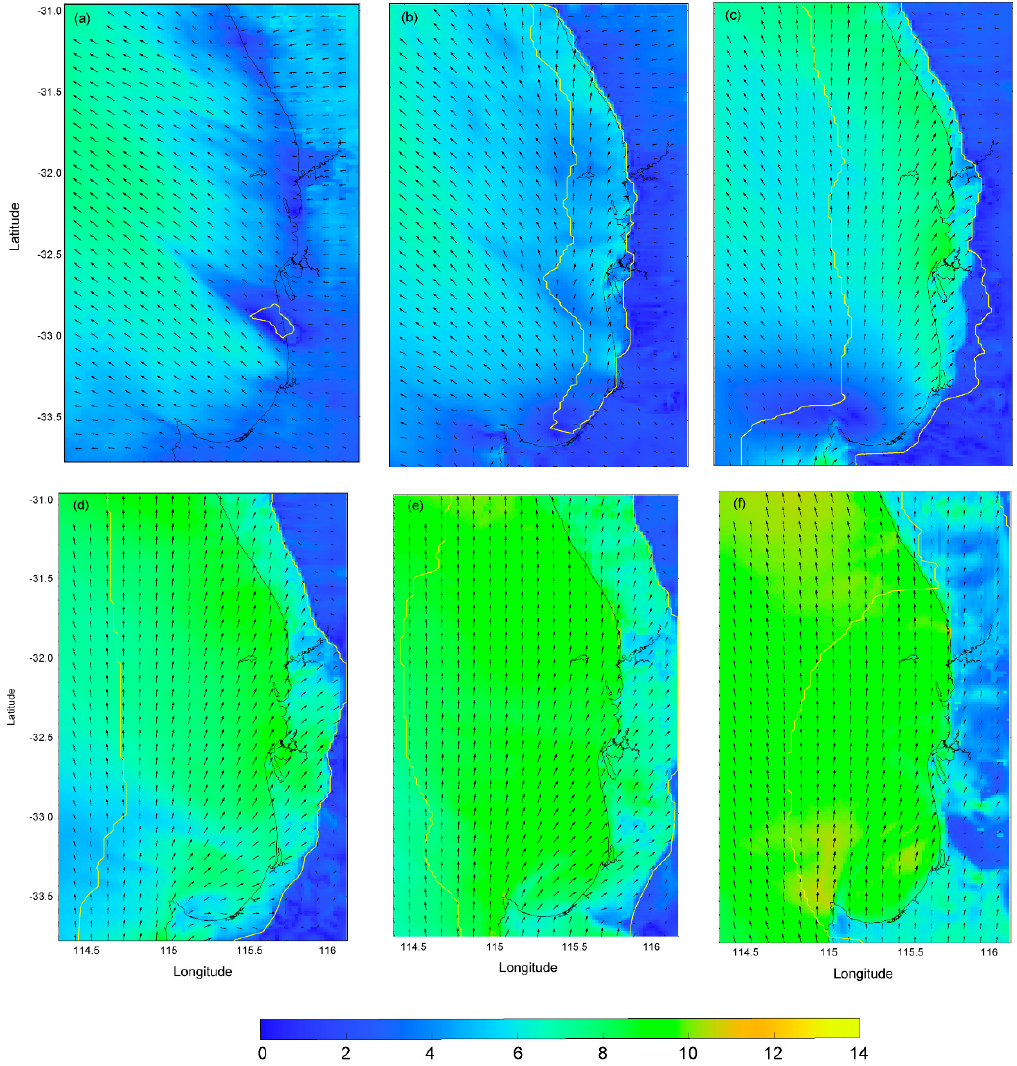
Figure 9. Time series (two-hourly intervals) of the spatial distribution wind vectors for south-west Australia during a typical sea breeze cycle predicted from the WRF model on 23 February 2017. ( a ) 0800; ( b ) 1000; ( c ) 1200; ( d ) 1400; ( e ) 1600; and ( f ) 1800. The contour outline of the sea breeze cell is shown by the yellow line. The colours represent wind speed in ms − 1 .